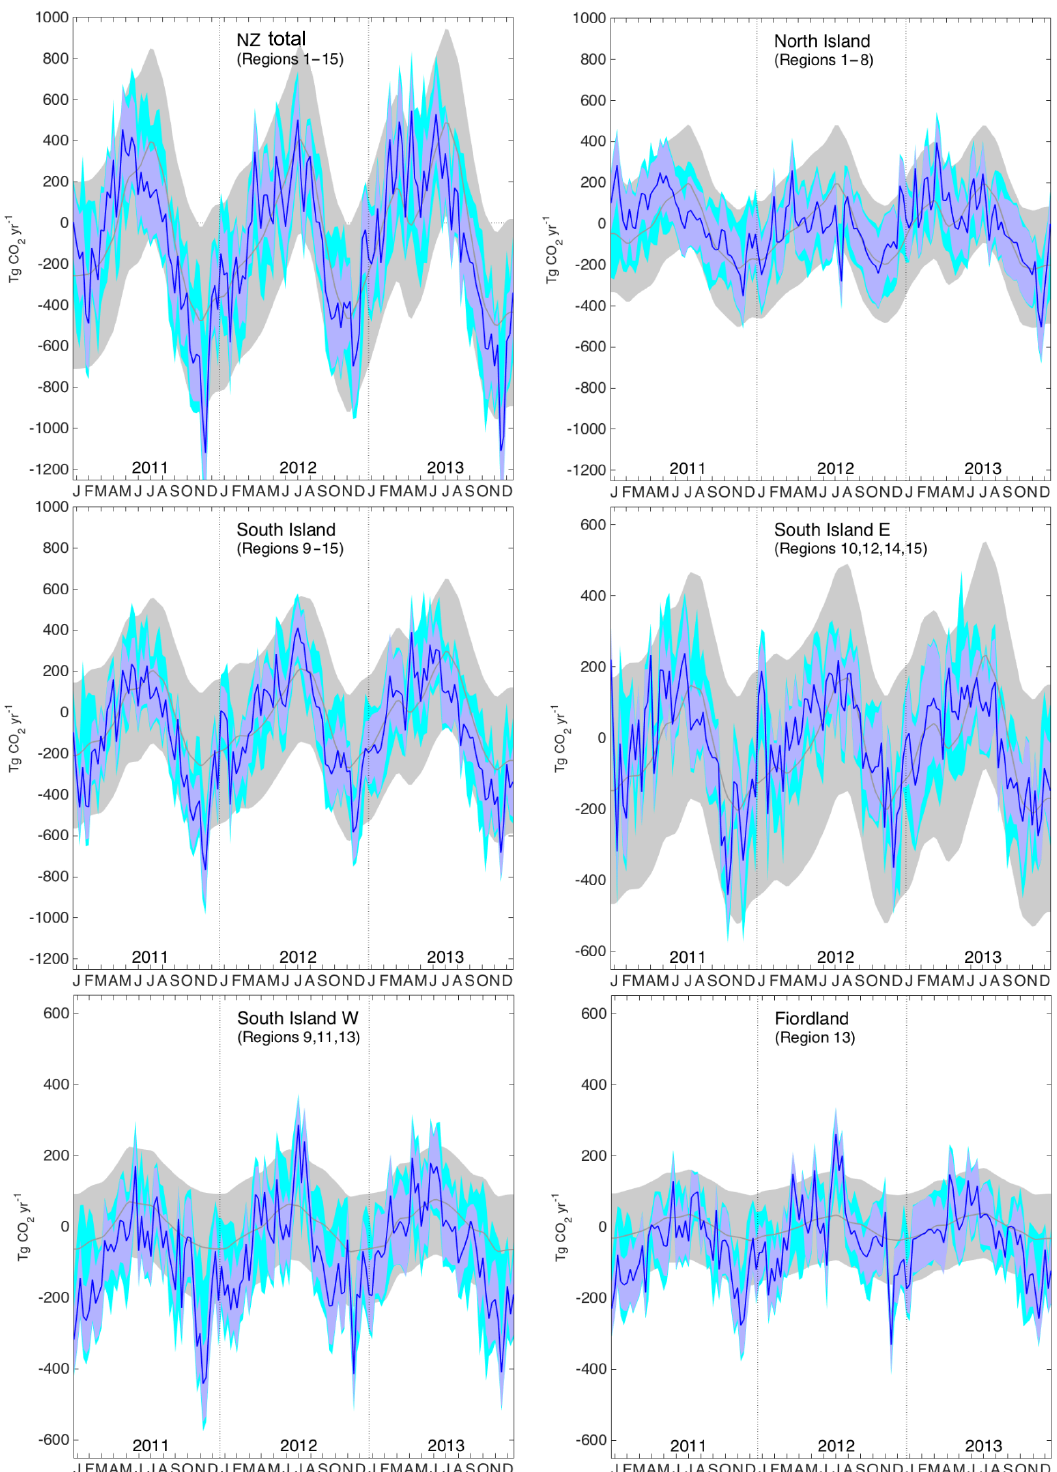
Figure 10. Weekly CO 2 fluxes in 2011–2013 from selected regions, in TgCO 2 yr − 1 . Prior flux estimates are shown in grey, and the inversion results are shown in blue. Shaded areas represent flux uncertainty (1 σ ). The cyan shade represents the extra uncertainty obtained from the sensitivity cases (Sect. 7.4). Note that there is a one-off change in scale of the flux axis for sub-island scale regions. A positive flux indicates a net release of CO 2 to the atmosphere, while a negative value indicates uptake by the land biosphere. Regional indices in parentheses correspond to Fig.